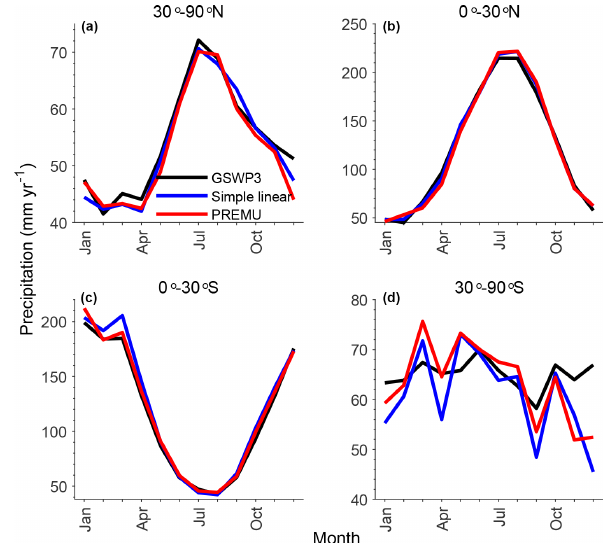
Figure 11. (a) The seasonal cycle of 30–90 ◦ N latitude land average precipitation in 1987–2016 from GSWP3, simple linear method and PREMU; (b) 0–30 ◦ N; (c) 30 ◦ S–0 ◦ ; (d) 90–30 ◦